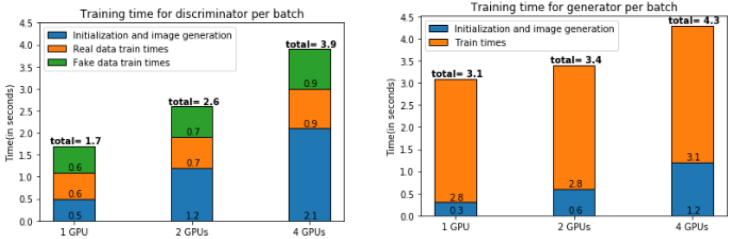
Figure 1. (left) Discriminator training times divided between processing, real data training and fake data training. (right) Generator training times. Times are quoted for one data